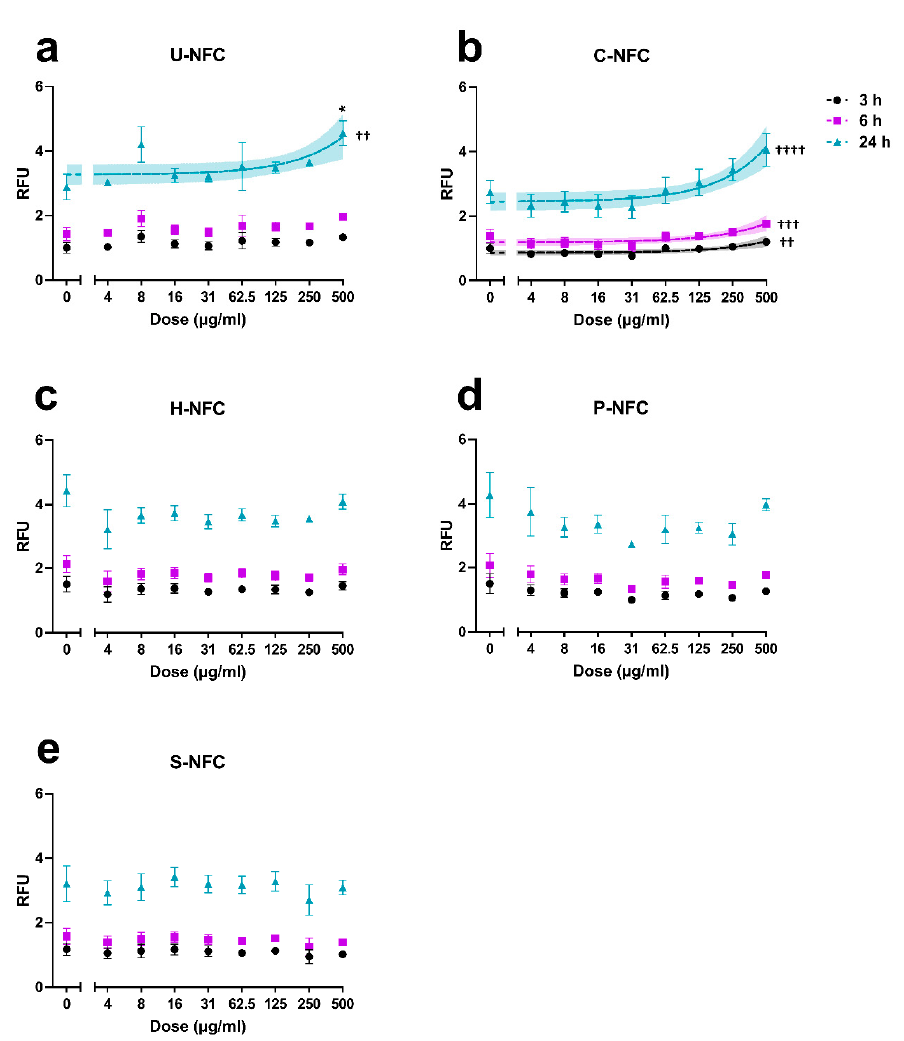
Figure 5. Induction of intracellular reactive oxygen species (ROS) by the nanofibrillated cellulose (NFC) materials. The production of ROS was assessed at 3, 6, and 24 h exposure to ( a ) U-NFC, ( b ) C-NFC, ( c ) H-NFC, ( d ) P-NFC and ( e ) S-NFC. Data are expressed as relative fluorescence units (RFU) and presented as the mean ± standard error of the mean. Significant linear dose-responses are plotted with 95% confidence interval (colored areas). Statistical significance in comparison with control cultures (one-way ANOVA): * p < 0.05. Statistical significance, linear regression: †† p < 0.01; ††† p < 0.001; †††† p <